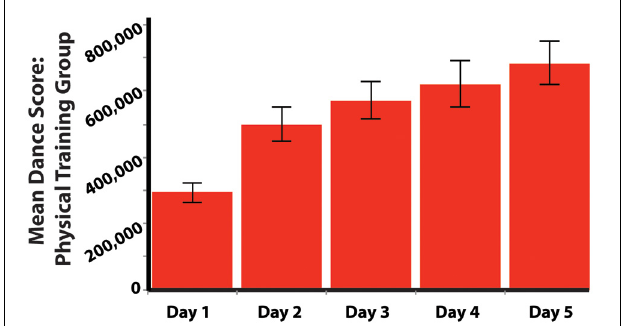
FIGURE 2 | Mean dance scores for the physical training group across the experiment. Participants in the physical training group practiced the same two dance sequences across the 4 days of training, and then performed the same sequences one final time on the post-training dance test on Day 5. See main text for how scores were calculated based on Xbox Kinect™